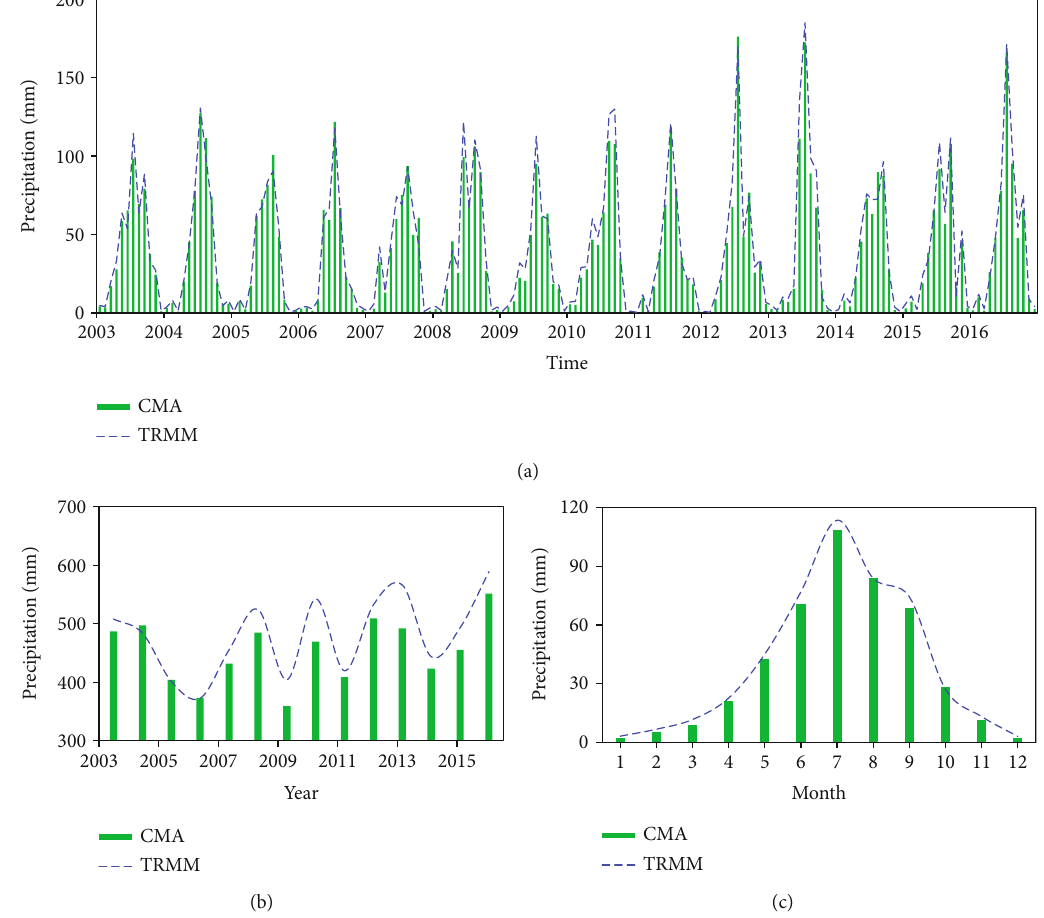
Figure 3: Comparison between data from CMA and TRMM precipitation data: (a) monthly time-series data; (b) yearly time-series data; (c) mean seasonal time-series